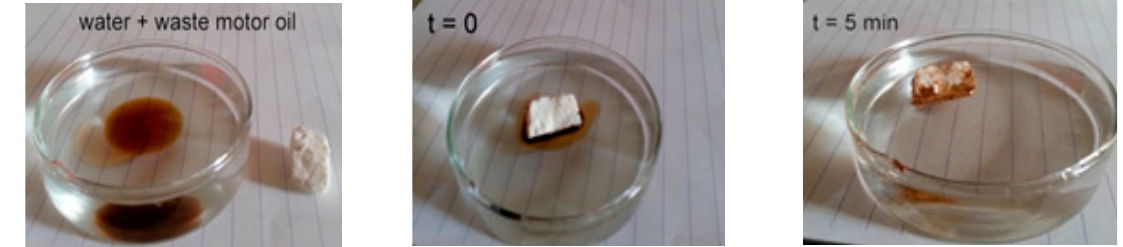
Figure 9. Waste motor oil absorption test of the silanized cellulose aerogel with MEMO silane.